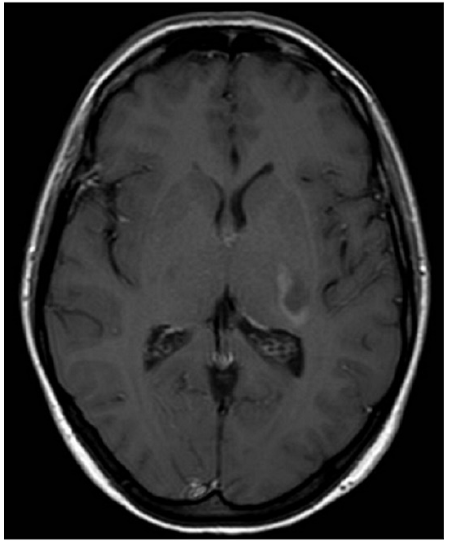
Figure 2. T1-weighted axial MRI post gadolinium.